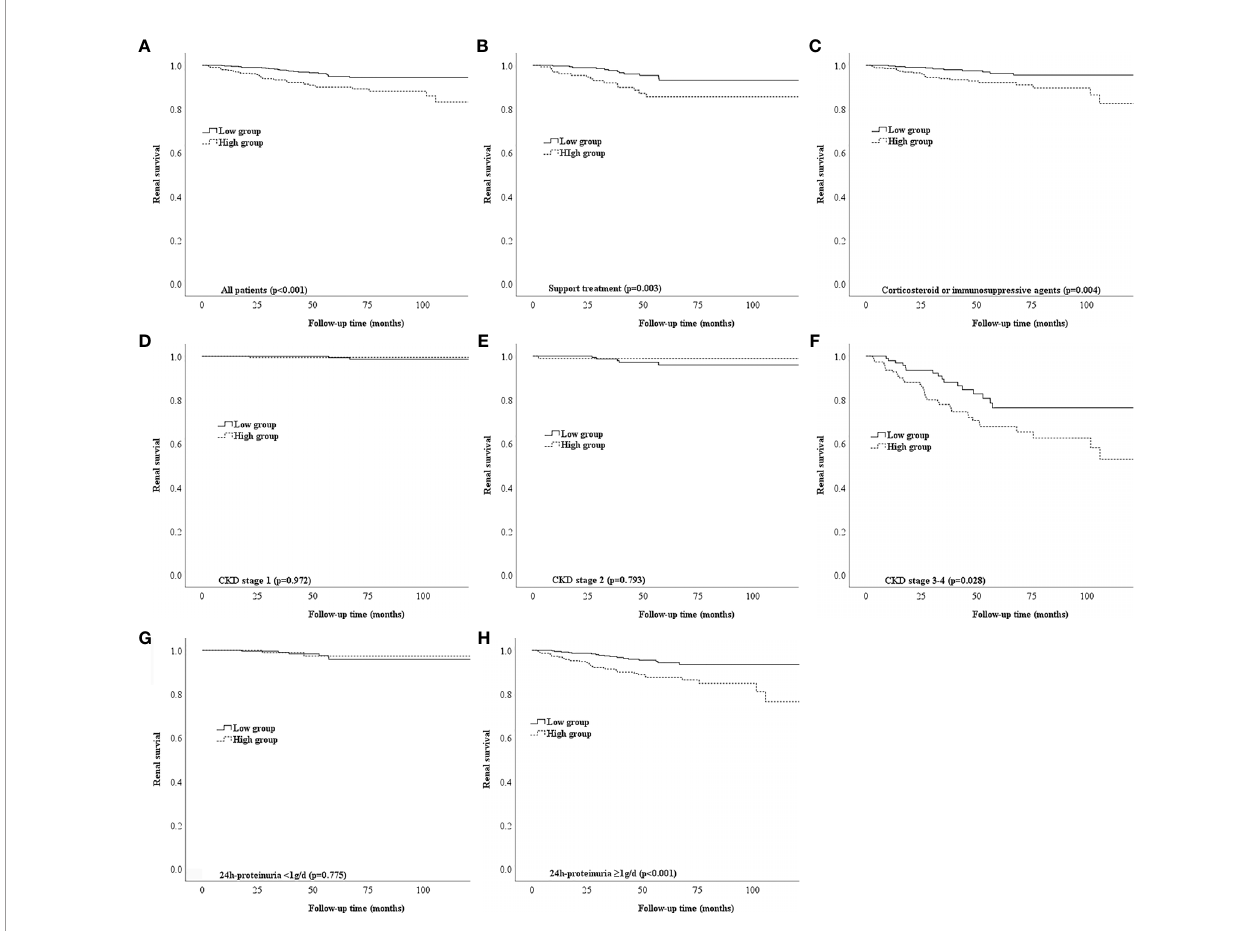
FIGURE 3 | Different types of Kaplan-Meier analysis for the endpoint of ESRD. (A) Kaplan-Meier analysis for all patients to the endpoint of ESRD. (B,C) Kaplan- Meier analysis for patients with different treatment to the endpoint of ESRD. (D-F) Kaplan-Meier analysis for patients with different CKD stages to the endpoint of ESRD. (G, H) Kaplan-Meier analysis for patients with different urine protein to the endpoint of ESRD.